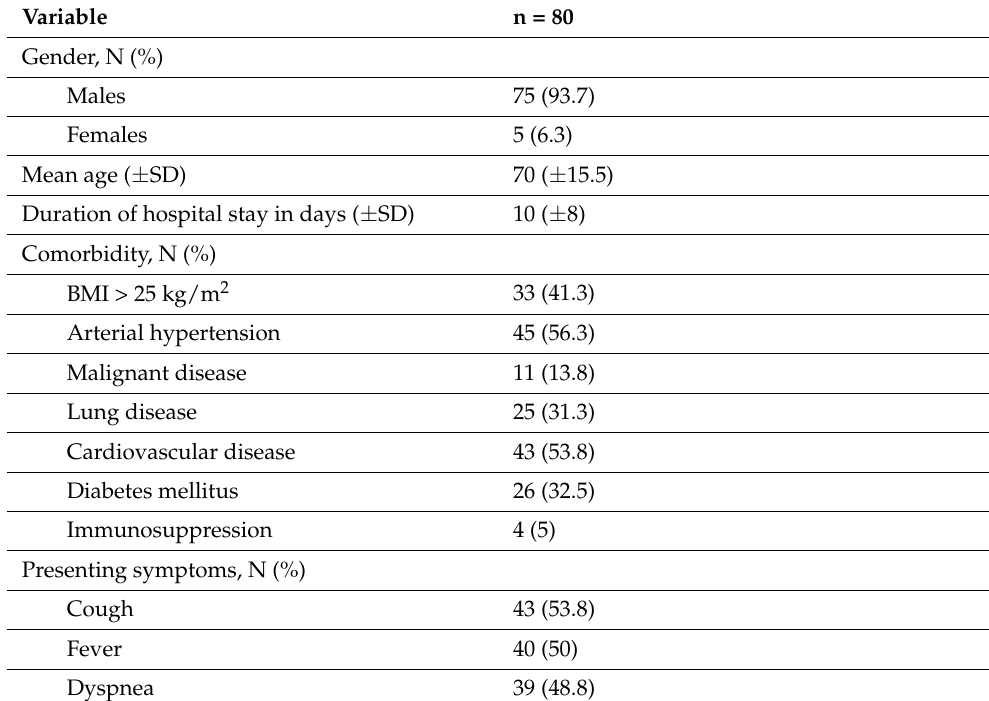
Table 1. Hospitalized patients with COVID-19 breakthrough